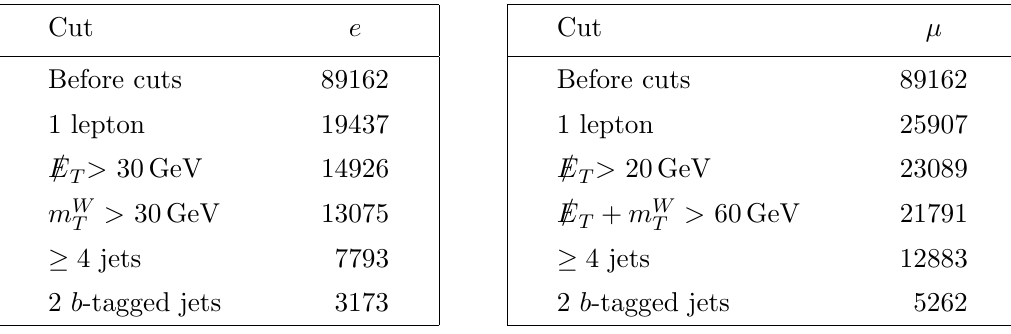
Table 4 . Cut(cid:13)ow table for semi-leptonic sample with m t = 172.5 GeV, separated by the identity of the lepton. The initial number of events is determined using the ATLAS integrated luminosity L = 20 : 2 fb (cid:0) 1 , and the production cross section as calculated using MadGraph5 aMC@NLO .